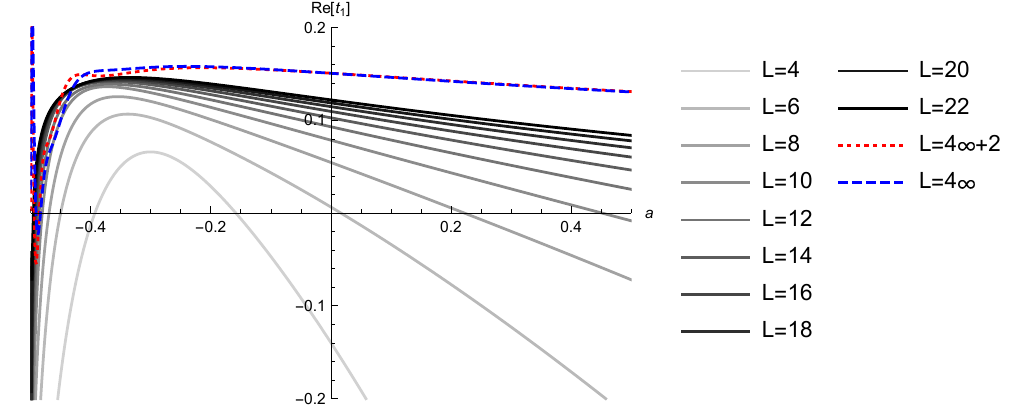
Figure 19 . Plots of the real part of the coefficient of the lowest level state c 1 | 0 i for the “ghost brane” solution Φ G at the truncation level L . The dotted and dashed lines are extrapolations to a L = 4 k + 2 ( k → ∞ ) and L = 4 k ( k → ∞ ), respectively. The horizontal axis denotes the values of the parameter a .